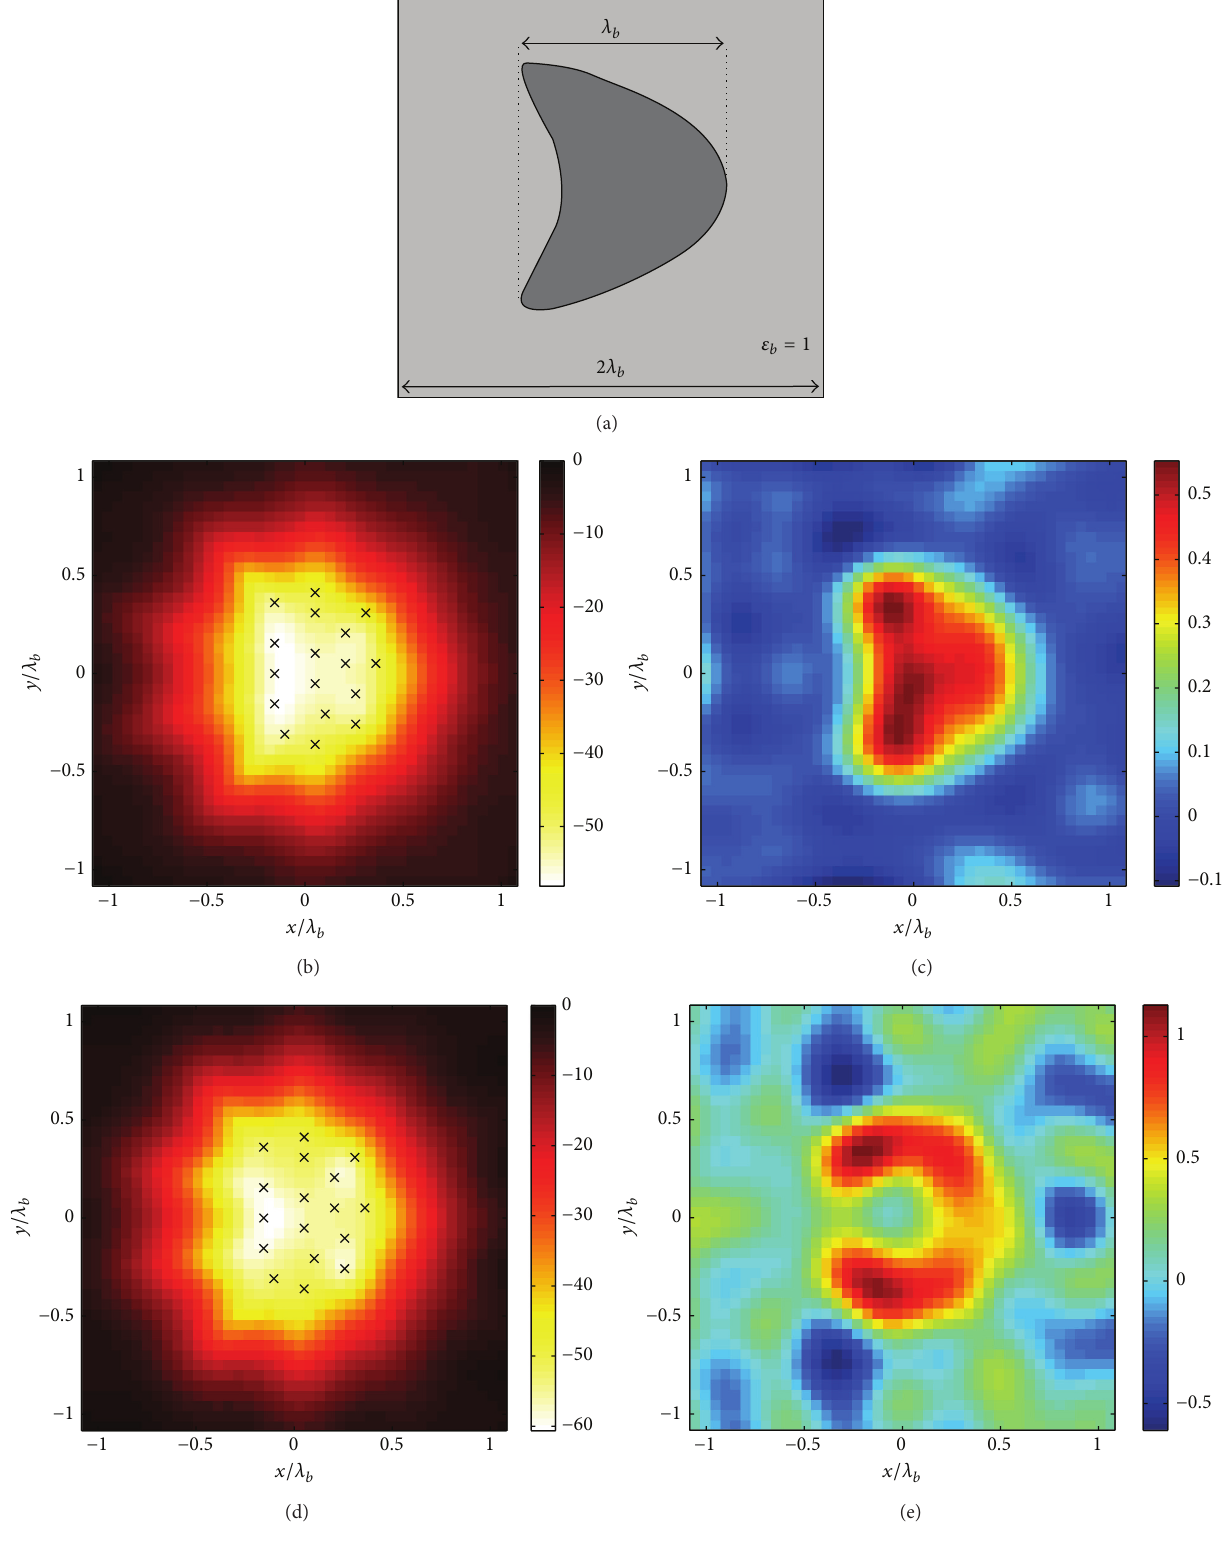
Figure 3: Kite example: (a) layout of the reference profile; (b) support estimation via LSM indicator and the selected pivot points ( 𝑁 𝑝 = 17) and (c) real part of the retrieved contrast profile for 𝜀 𝑠 = 1 . 5; (d) support estimation via LSM indicator ( 𝑁 𝑝 = 17) and (e) real part of the retrieved contrast profile for 𝜀 𝑠 = 2. The truncation index in the TSVD inversion scheme is 𝑇 = 73 and 𝑇 = 52,